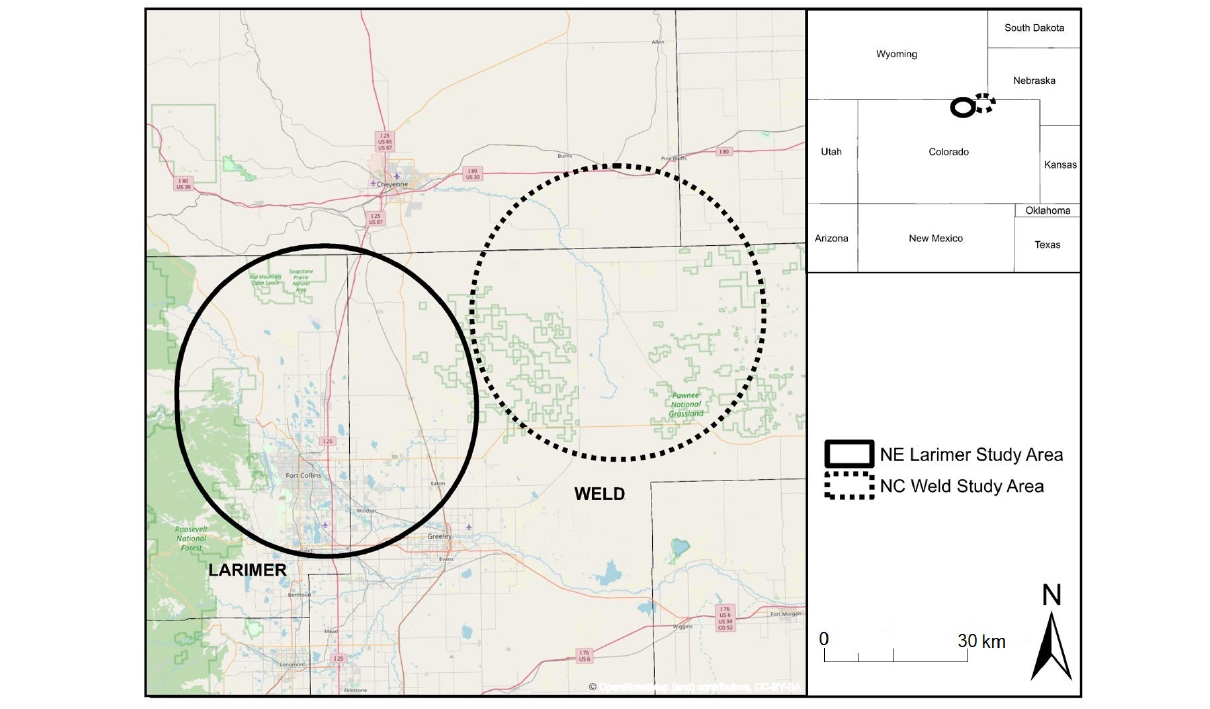
Fig. 1 . The study sites in northeastern Larimer County and northcentral Weld County, Colorado (ESRI 2011). The study area symbols indicate the average extent of participant agricultural